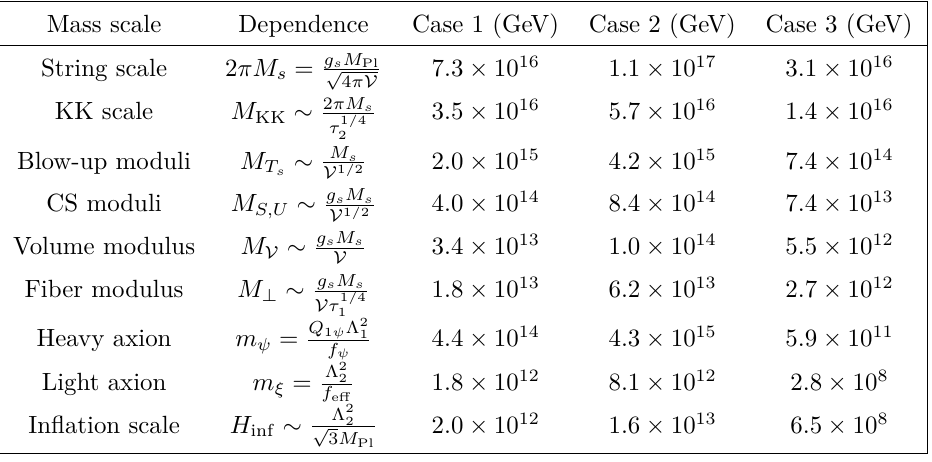
Table 3 . Mass scales for the three benchmark cases introduced in table 2, in units of